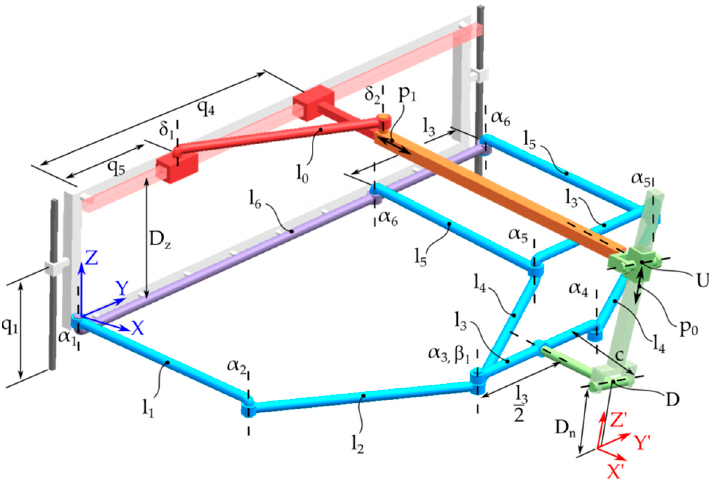
Figure 4. PRO-HEP-LCT parallel robotic system (CAD model).